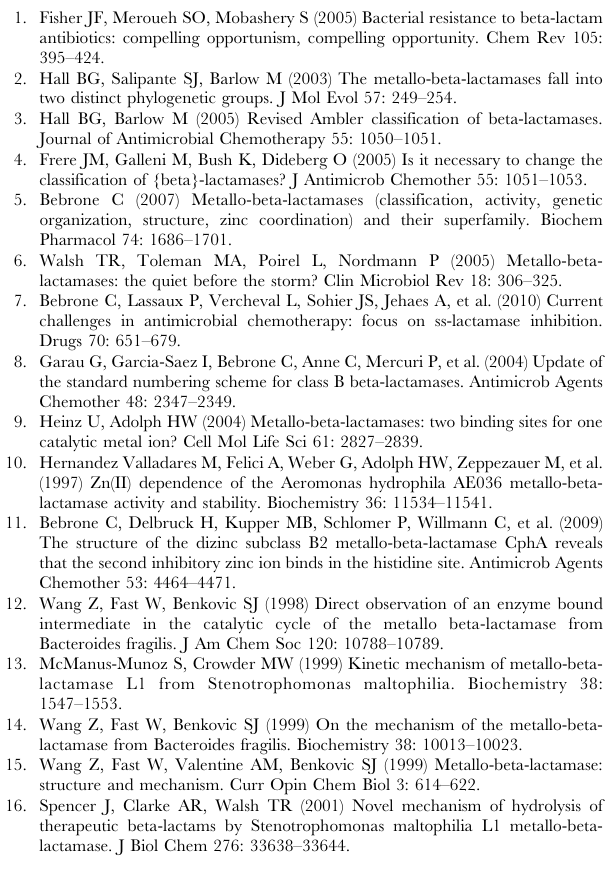
Table S1 Energetics of the rotation of the hydroxyethyl group of hydrolyzed biapenem. Metadynamics of biapenem in solution and in the enzyme (Configuration No. 4 in Table 1 and Fig. 6A ) were carried out starting from conformation A Table S2 Sensitivity of the calculated energies to the functional used. Some of the points of the energy profiles for the cyclization reaction of hydrolyzed biapenem in solution ( Fig. 4A ) and in the enzyme (Configuration No. 4 in Table 1 and Fig. 6A ) were calculated also using the M06 functional. Energies are in